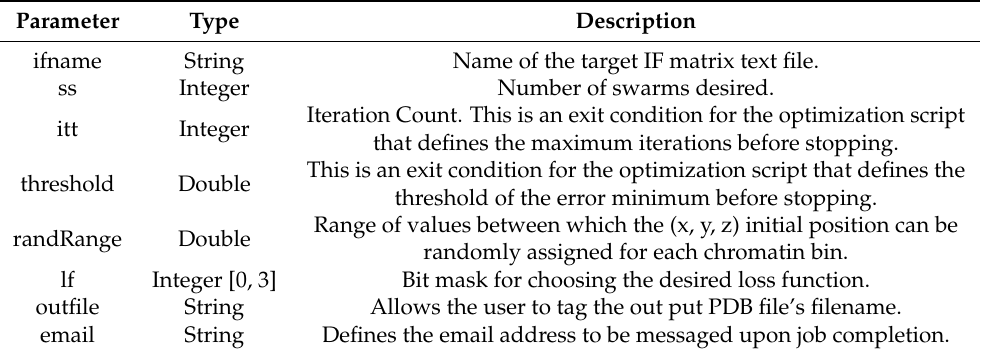
Table 2. GET http://biomlearn.uccs.edu:5001/process, (accessed on 31 January 2023 ).